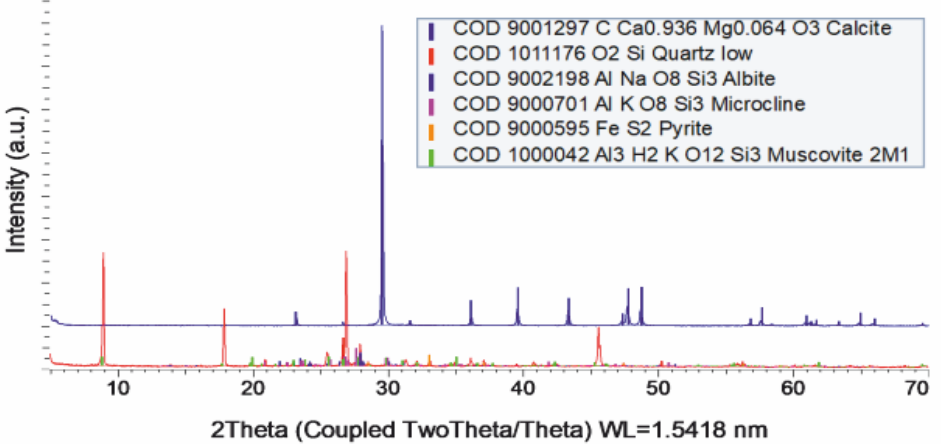
Figure 4. XRPD of both white marble powder (M, blue line) and residue insoluble to acid attack (R, red line).